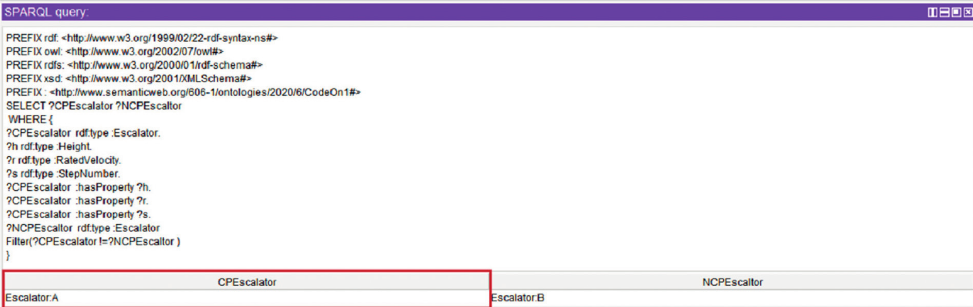
Figure 18: The integrity check results in